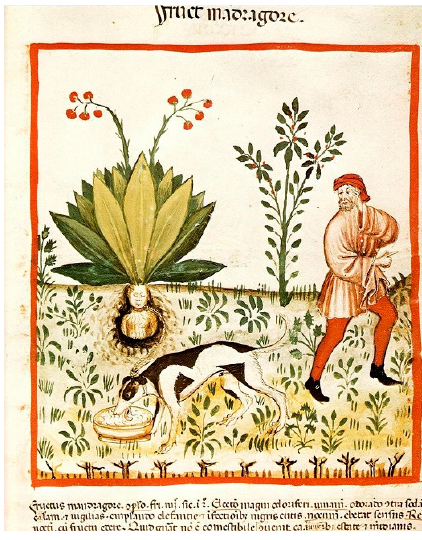
Figure 2. Tacuinum Sanitatis—Mandrake Dog (1389).